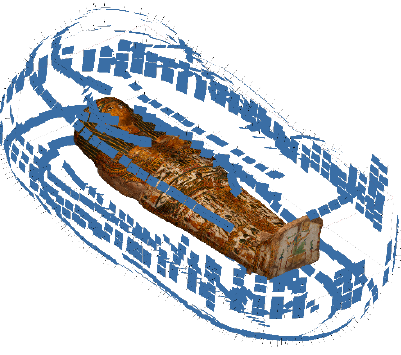
Figure 10. Wraparound network.